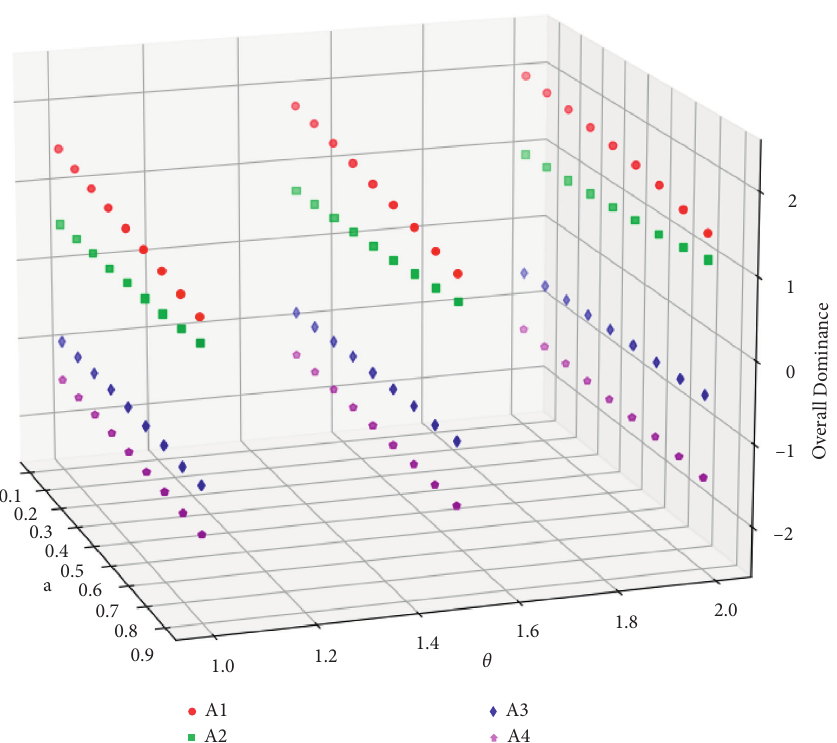
Figure 5: The pictorial expressions of the dominance values with different values of α and θ in case of q �